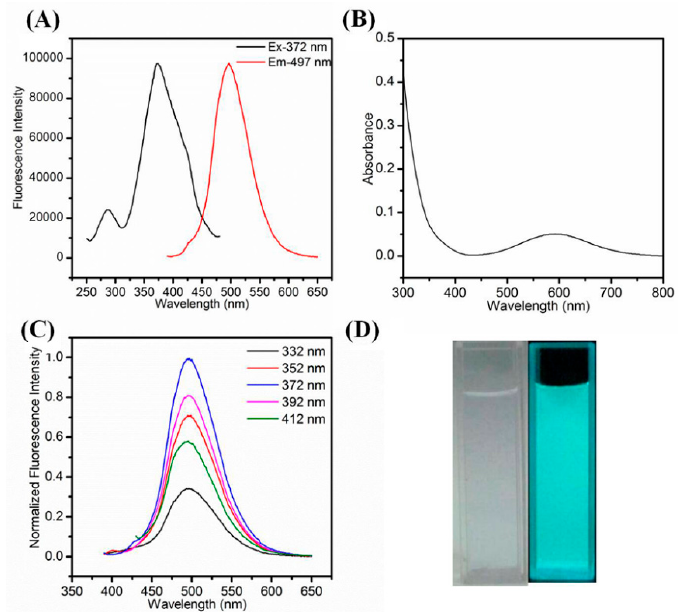
Figure 3. ( A ) Fluorescence excitation and emission spectra. ( B ) UV-vis absorption spectra; ( C ) normalized fluorescence emission spectra the Cu NCs@GSH upon various excitation wavelengths ranging from 332 nm to 412 nm; ( D ) photograph of Cu NCs@GSH under daylight and 365-nm UV light.